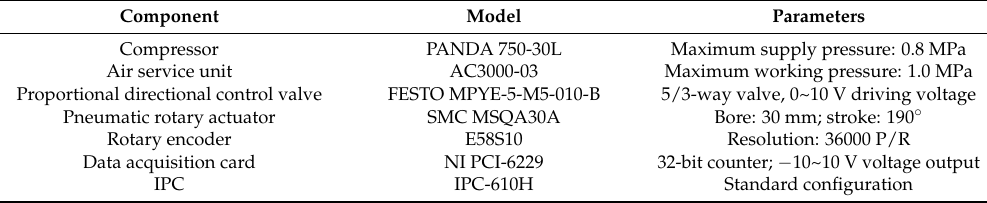
Table 1. The specific models of the main components.